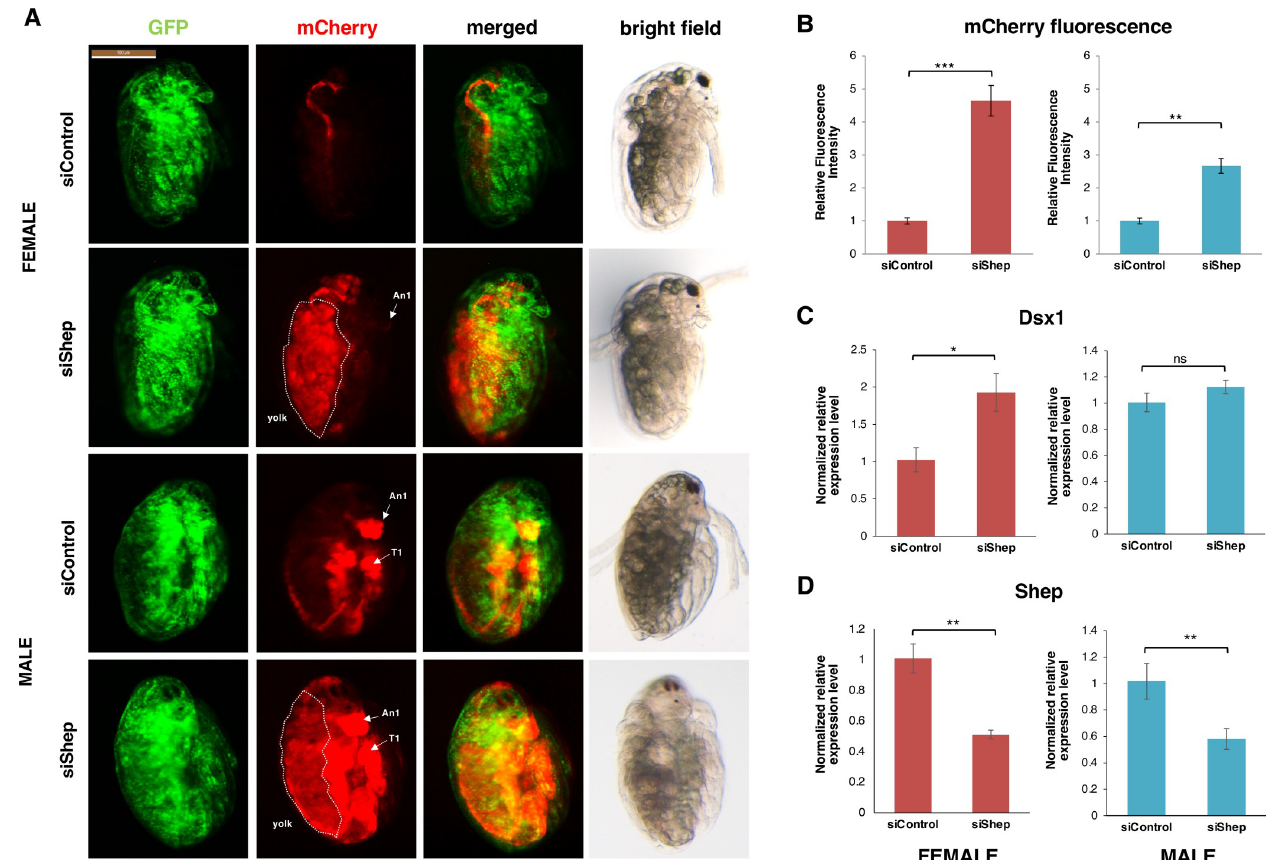
Fig 2. Shep loss of function analysis. (A) Lateral view of female and male embryos of Dsx1 reporter strain injected with control siRNA and Shep siRNA and observed at 48 h after injection. mCherry fluorescence allowed visualization of Dsx1 expression while GFP fluorescence in the nucleus enabled observation of body structures. The merged images of mCherry and GFP and the bright field images were used to understand the localization pattern of mCherry expression. An1: first antennae, T1: first thoracic leg, dotted lines: yolk area. (B) Relative mCherry fluorescence intensity calculated between Shep siRNA- and control siRNA-injected female (red) and male (blue) embryos. Error bars indicate the standard error of the mean (n = 5). (C) Gene expression profile of Dsx1 in control siRNA- and Shep siRNA-injected female (red) and male (blue) embryos. (D) Gene expression profile of Shep in control siRNA- and Shep siRNA- injected female (red) and male (blue) embryos. RT-qPCR results are shown as expression levels normalized with housekeeping genes L32 , L8 and Cyclophilin and relatively compared to the control. Error bars indicate the standard error of the mean (n = 3). � p < 0.05, �� p < 0.01, ��� p < 0.001, ns: not significant (Student’s